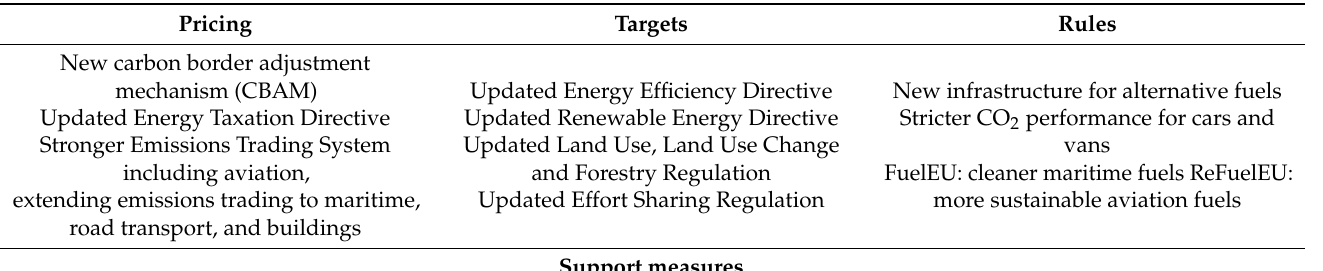
Table 1. Overview of the EC’s ‘Fit for 55’